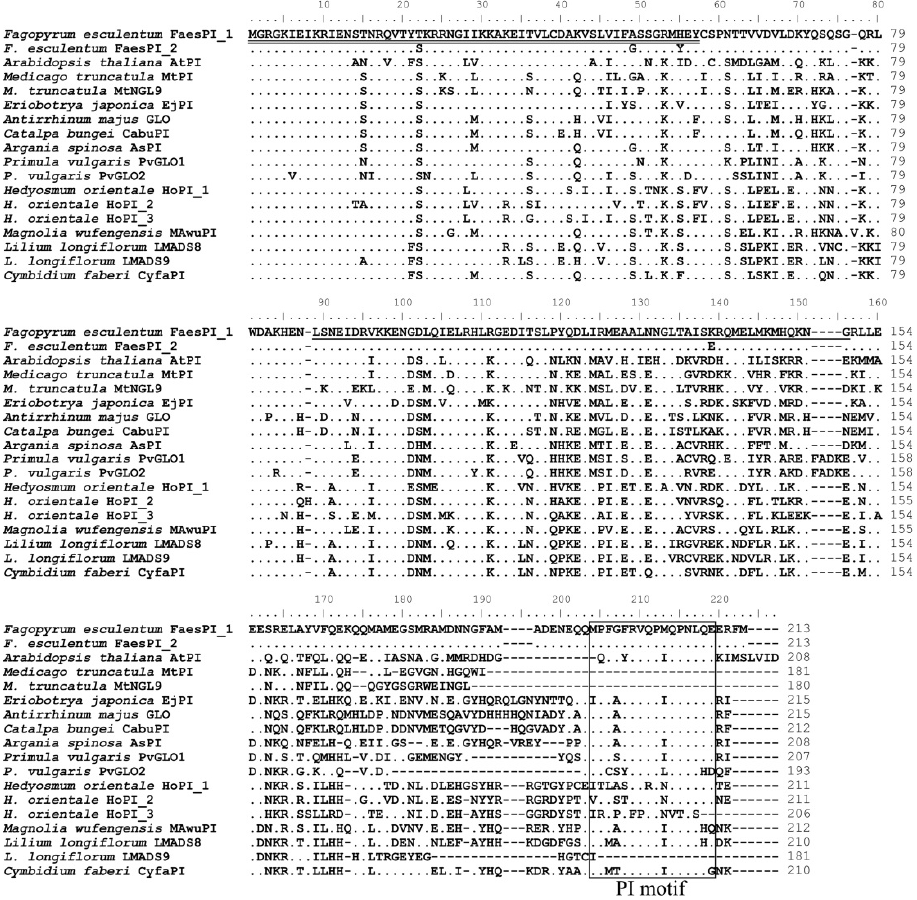
Figure 2. Phylogenetic tree of FaesPI_1 , FaesPI_2 , and other B-class MADS-box proteins from differ- ent species.